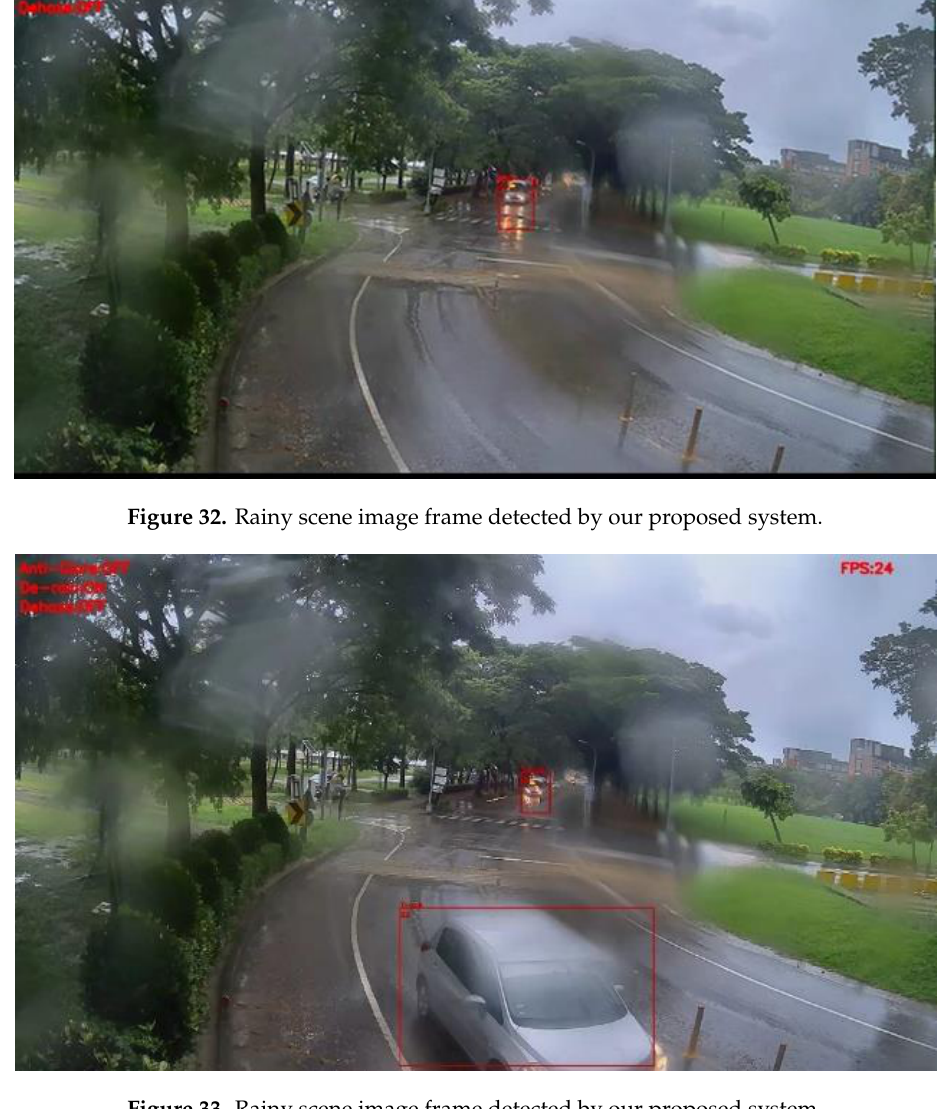
Figure 33. Rainy scene image frame detected by our proposed system.